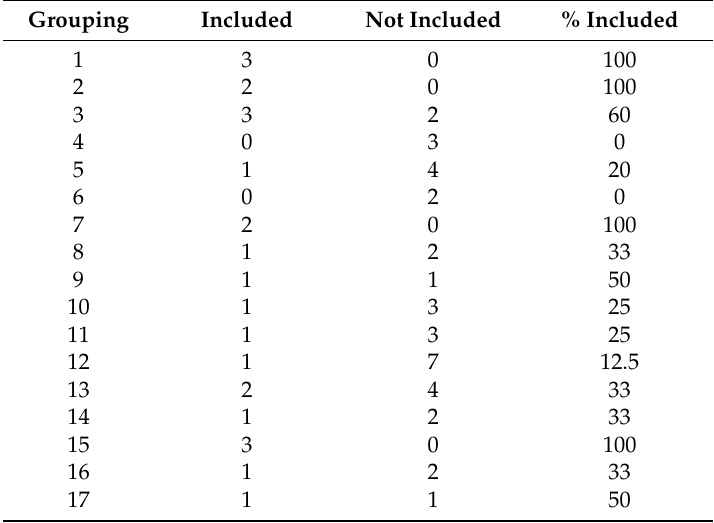
Table A20. Numbers of items from each grouping included and not included in Table